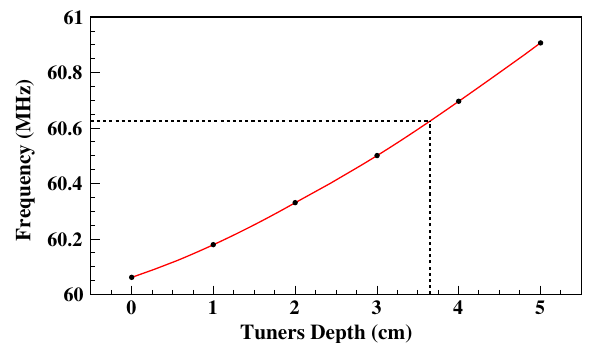
FIG. 18. Calculated RFQ frequency as function of uniform tuners depth. The dashed lines point to the operating frequency and the required depth to tune